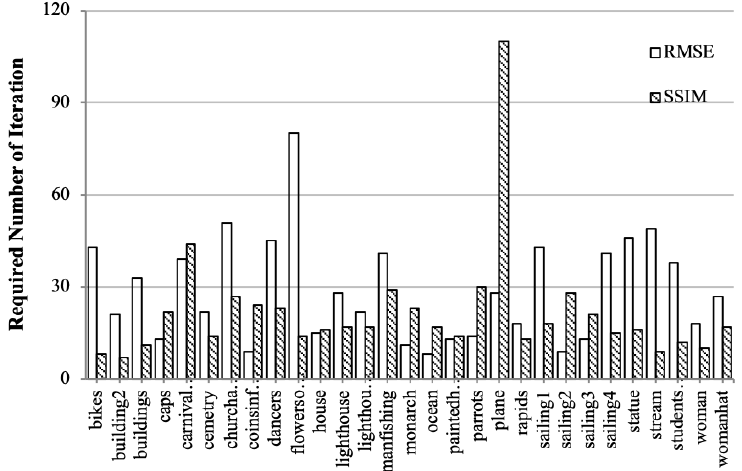
Figure 9. The required number of iterations to reach the convergence for the GS algorithms based on RMSE and SSIM.